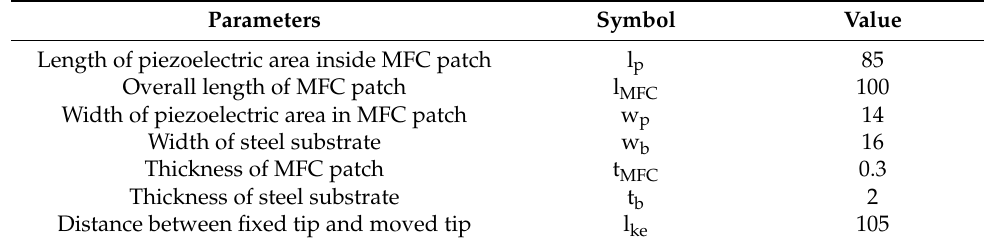
Table 1. Geometric parameters of bimorph (values in mm).